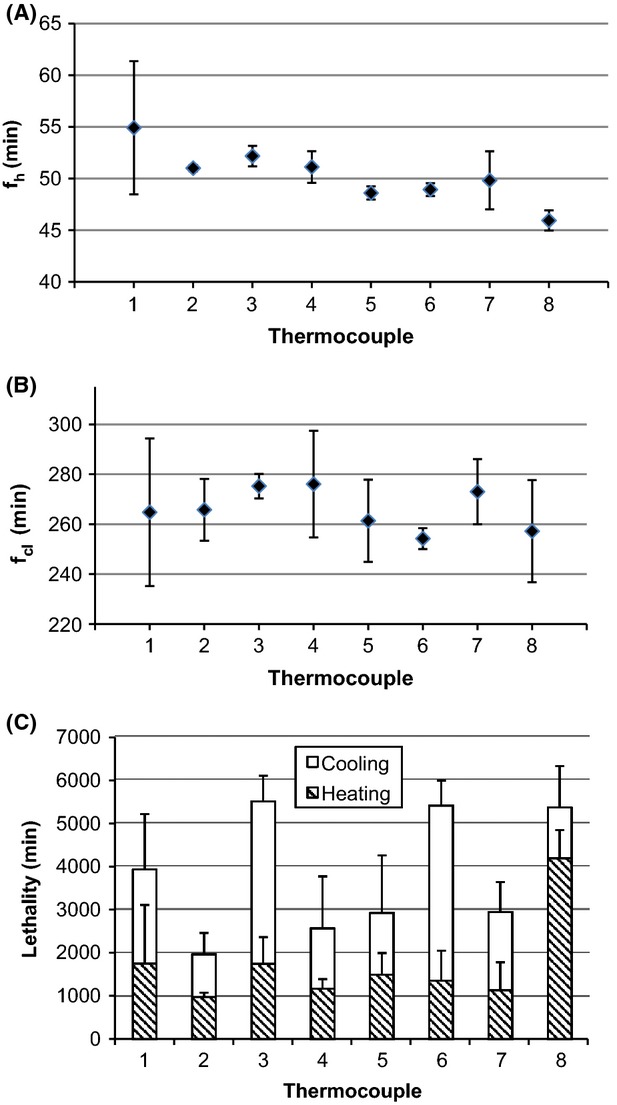
Average (95% CI) for (A) fh, (B) fcl, and (C) F82.2°C for heating and cooling of tomato juice, n = 3. Thermocouple location (height from bottom of container): 7.5 (geometric center), 6.5, 5.5, 5.0 (1/3 from the bottom), 4.5, 3.5, 2.5, and 1.5 cm, for thermocouple 1–8, respectively.